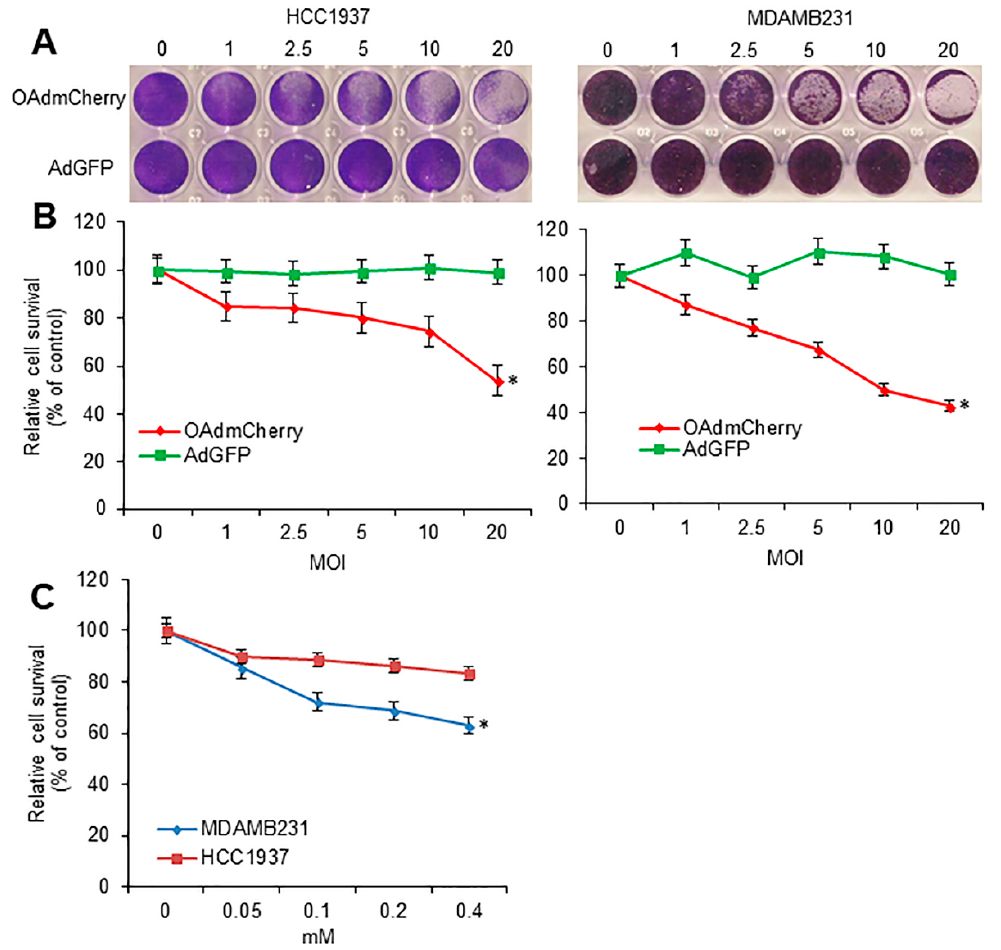
Figure 1. Oncolytic adenovirus expressing mCherry (OAdmCherry) and temozolomide (TMZ) have a cell-killing effect on human triple-negative breast cancer (TNBC) cells: ( A ) HCC1937 and MDA-MB-231 cells were infected with OAdmCherry or adenovirus expressing green fluorescent protein (AdGFP) at different multiplicity of infection concentrations for 72 h. Crystal violet staining was used to evaluate cytopathic effect (CPE). A representative staining of three independent experiments is shown. ( B ) Relative cell survival was calculated by measuring the absorbance of solubilized dye at 590 nm. ( C ) HCC1937 and MDA-MB-231 cells were treated with TMZ at different concentrations for 72 h. Cell survival was calculated by MTT assay. Results represent the mean of three repeated measurements ± standard deviation (SD; error bars) (* p < 0.05).